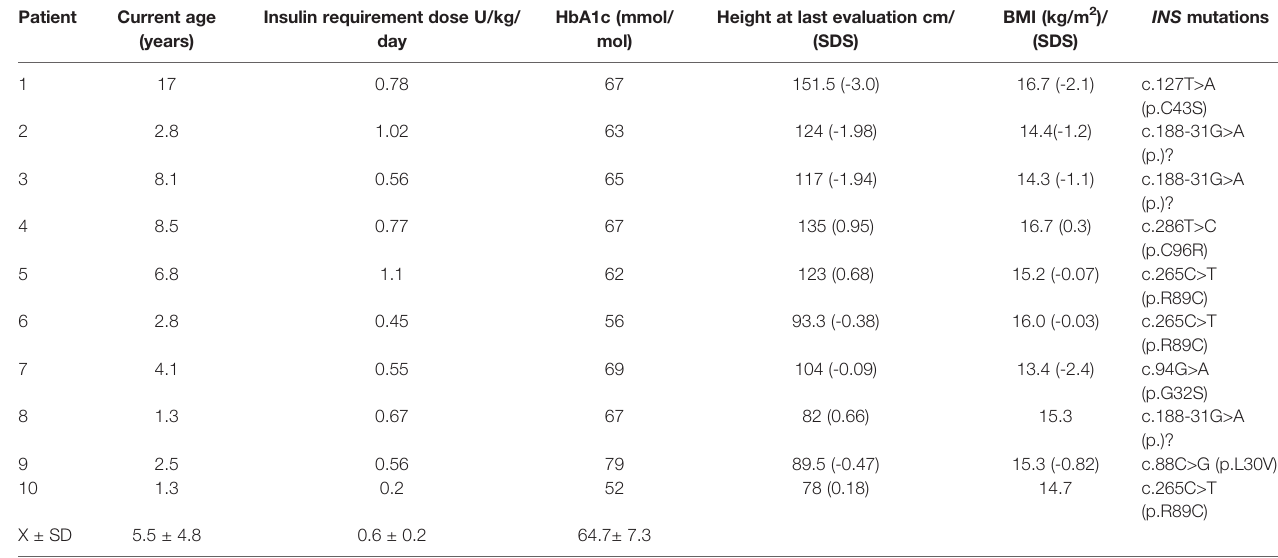
TABLE 4 | Clinical and biochemical characteristics at last